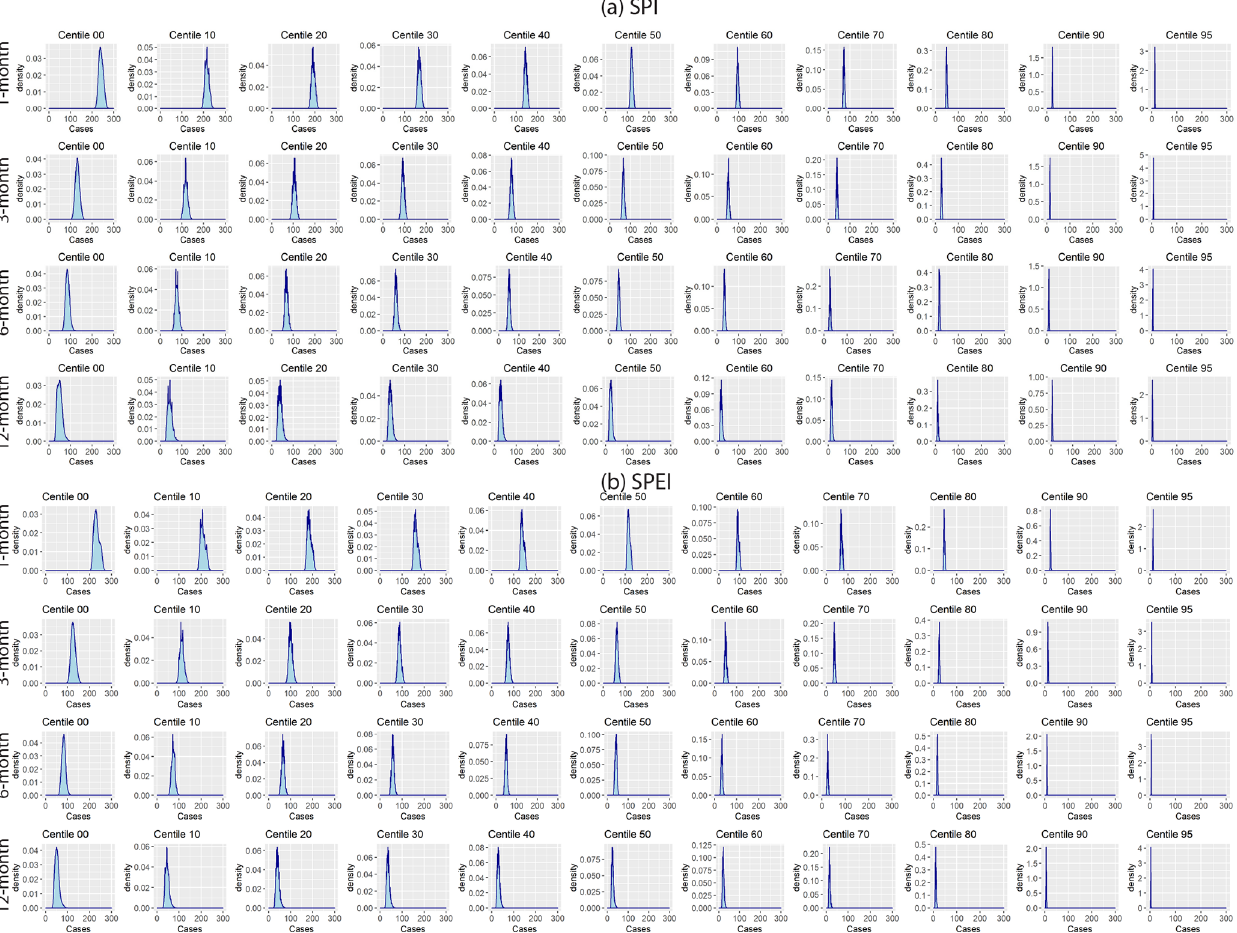
Figure 3. Probability density diagrams showing the number of cases corresponding to the peak-over-threshold drought duration–magnitude series at different percentiles and different timescales (1, 3, 6, and 12 months) using (a) SPI and (b)